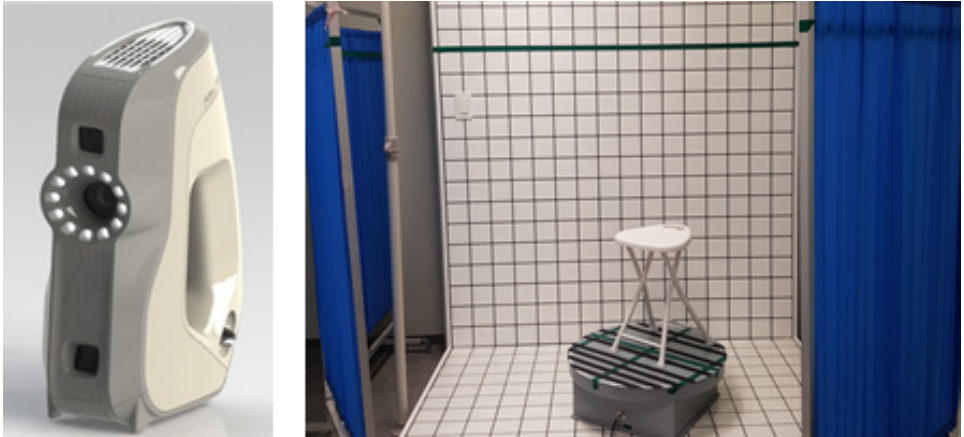
Figure 4. Artec Eva 3D Scanner ( left ) Rotating plate for scanning and measurement environment ( right ).